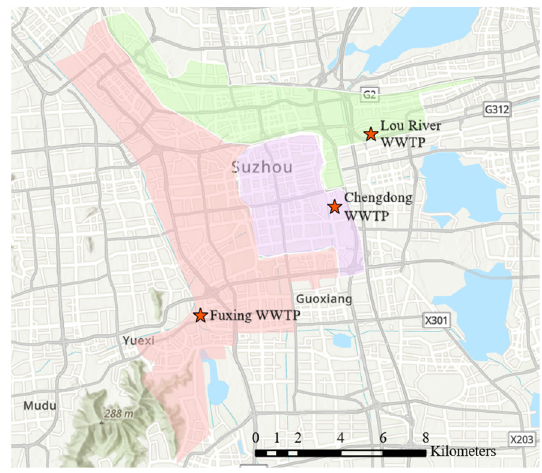
Figure 2. The three sewage systems in the study area and the and the distribution of multi-pump stations in the service area.